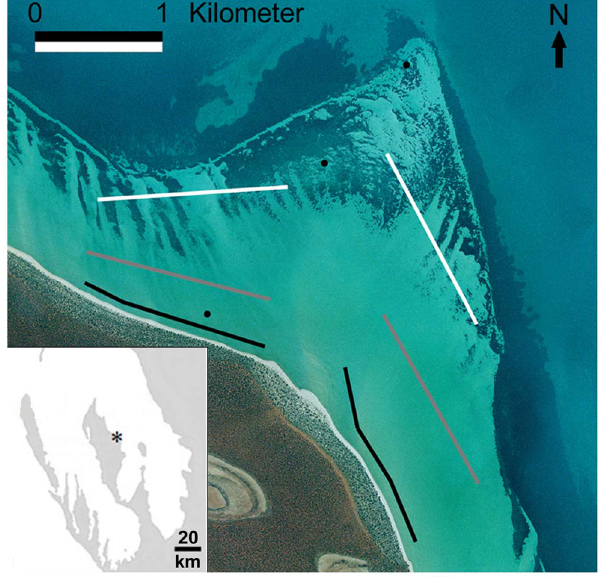
Figure 1. Study site: Cape Rose Flats, Shark Bay, Western Australia. The inset shows the location of the Cape Rose Flats within Shark Bay. The study site was divided into six transects representing nearshore (black), sand (grey), and patchy (white) microhabitats. Black circles represent the location of temperature data loggers.